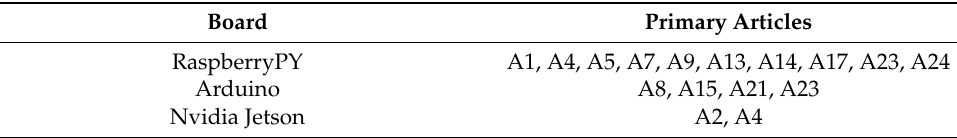
Table 12. RaspberryPY, Arduino, and Nvidia Jetson-based IoT